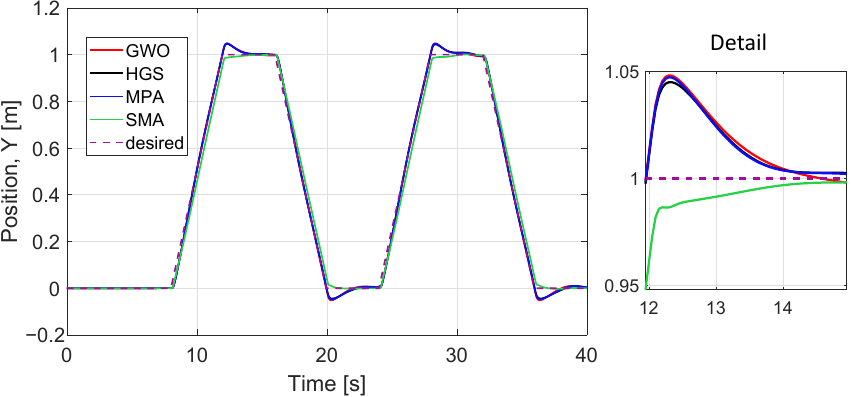
Figure 17. Comparison of tracking performance in Y–axis of the different algorithms evaluating parameters obtained with 100 individuals.